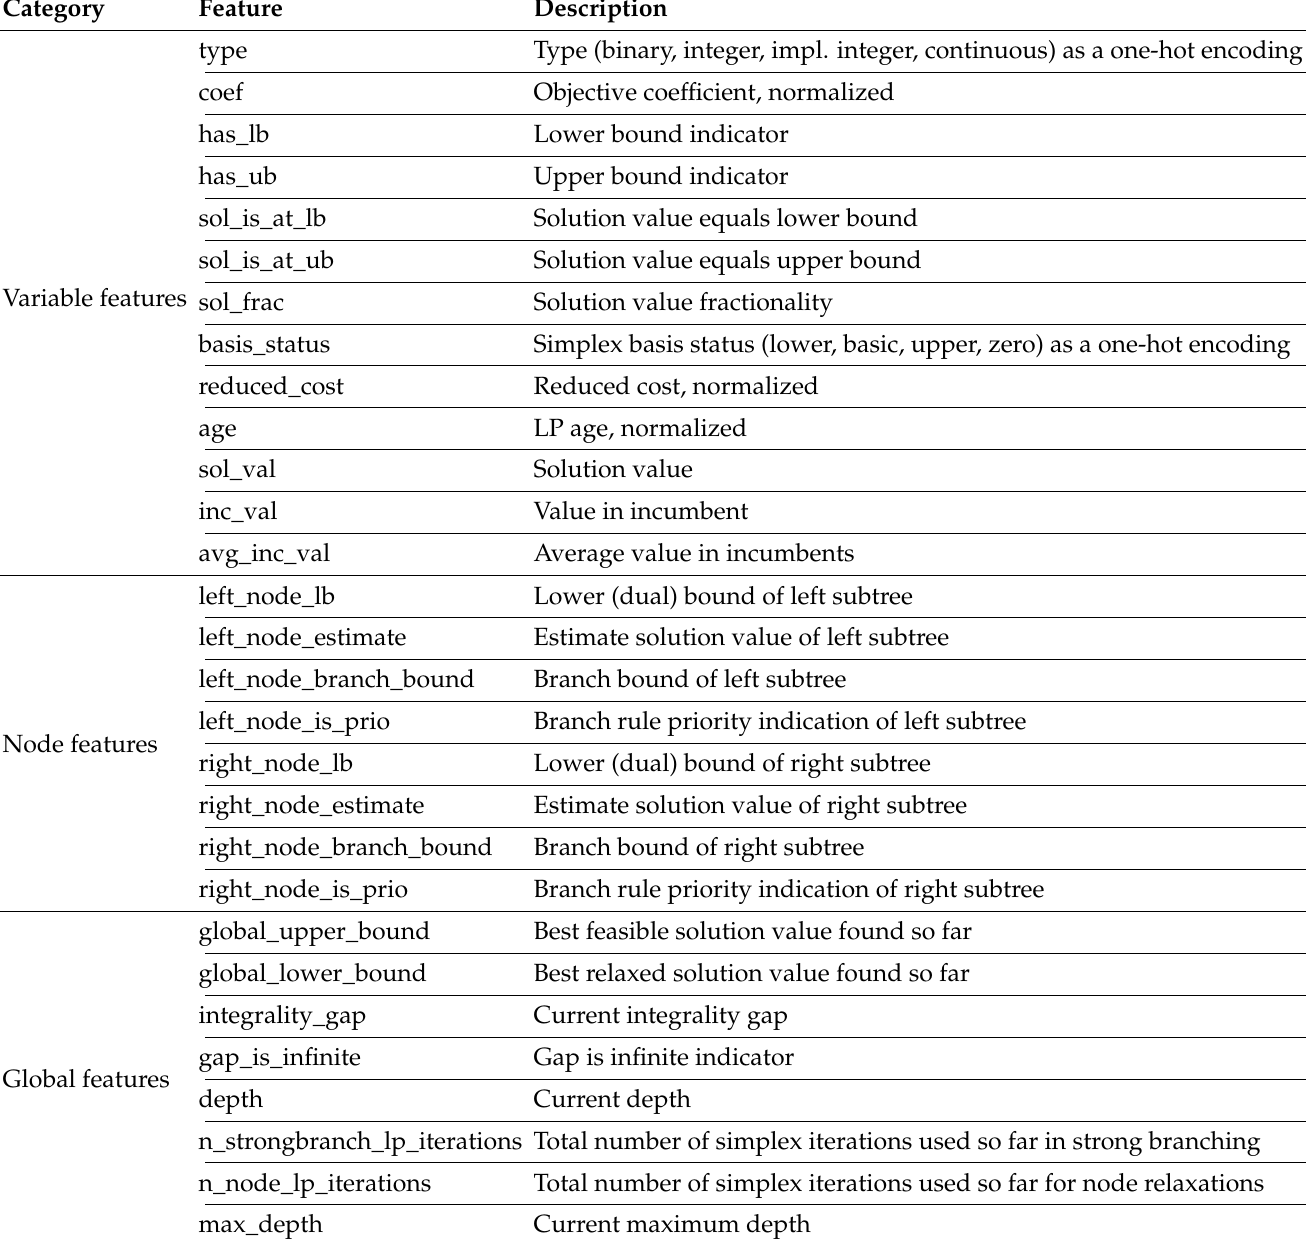
Table 1. Features that define a state. Variable features from Gasse et al.